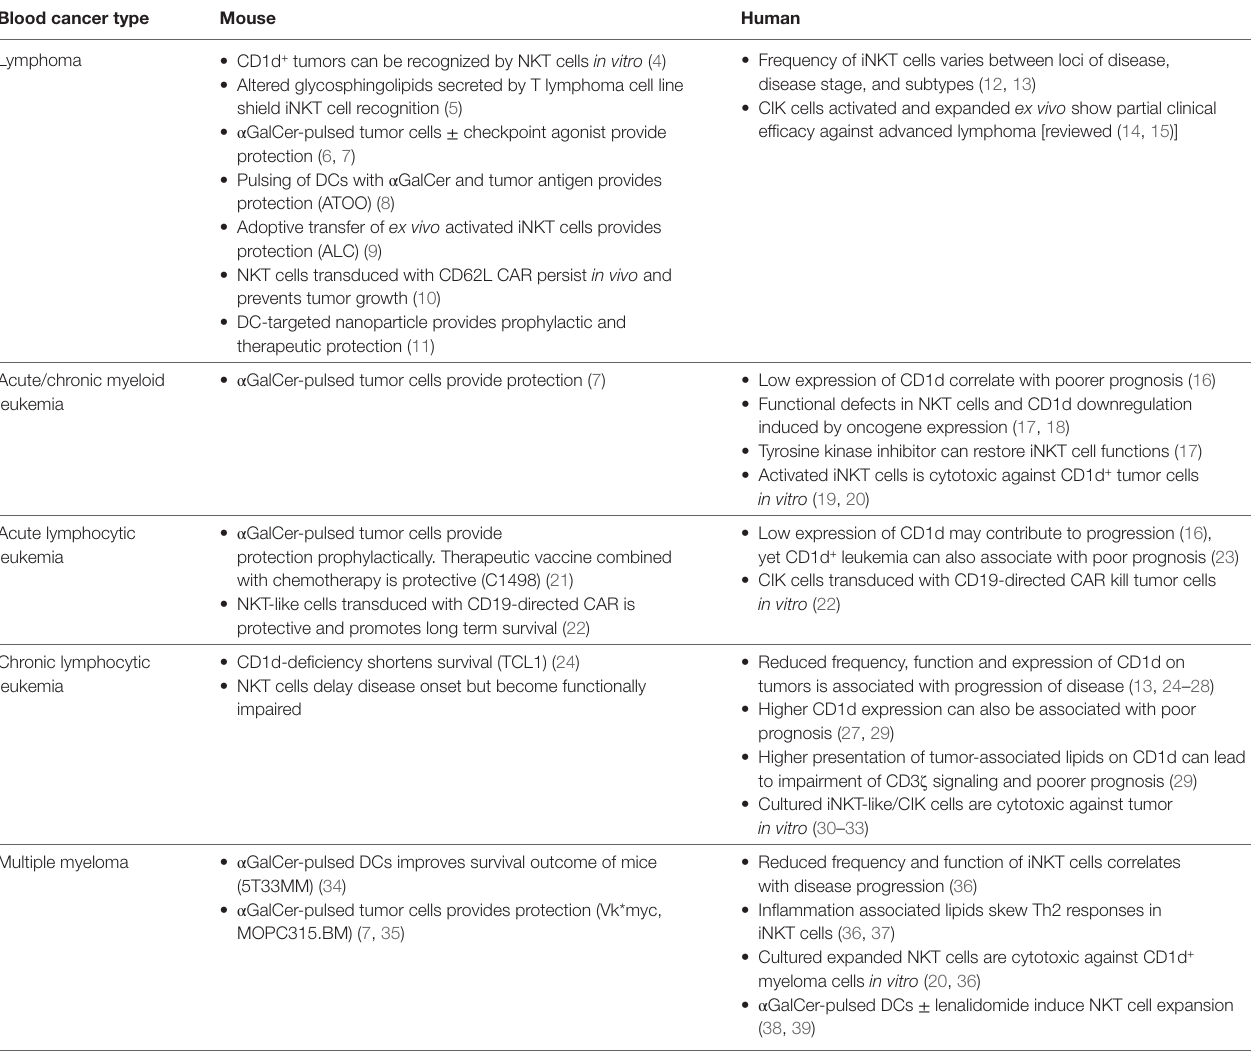
TaBle 1 | Evidence for the involvement and effective targeting of iNKT cells for blood cancer control in mice and